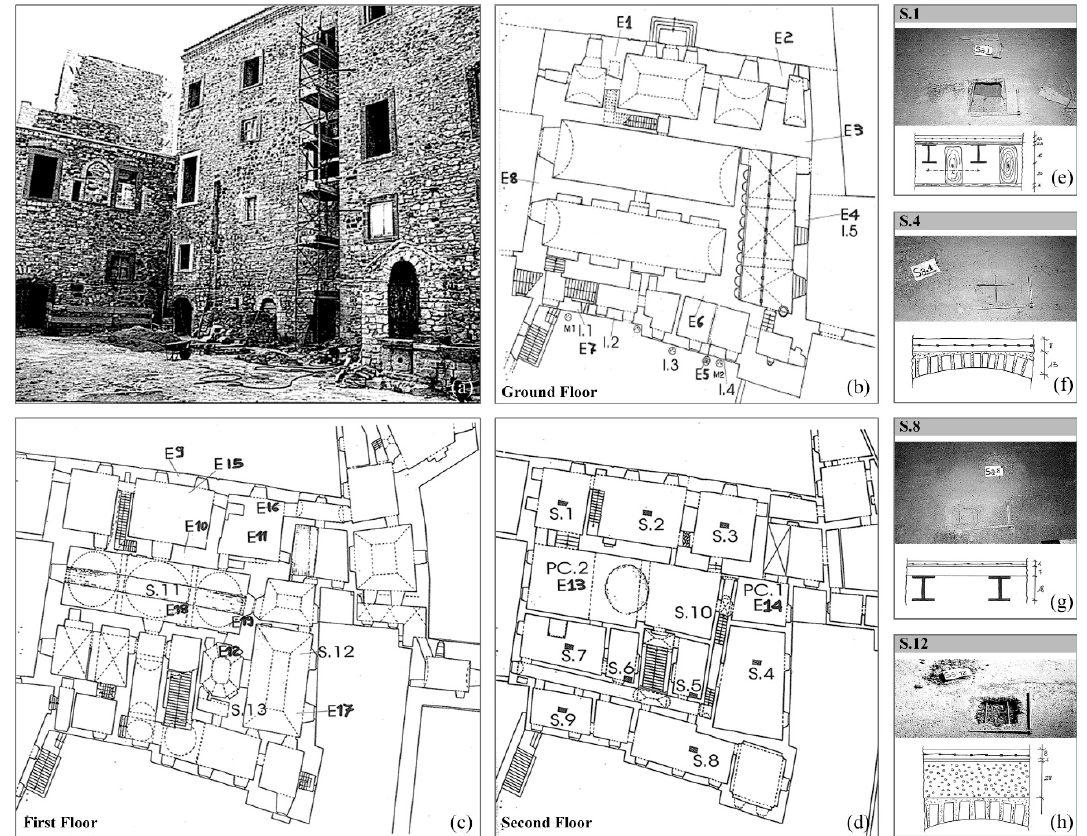
Figure 10. The castle during the 1999 survey ( a ), location of each test performed at the ground floor ( b ), the first floor ( c ) and the second floor ( d ) and results from 4 exploratory tests (from e – h ). The symbols used for the location of the tests are: M = flat jack tests, I = grout injection tests, PC = floor load tests, S = exploratory tests and E = endoscopic analyses (images adapted from the results of the 1999 survey by the Professor P. Rocchi).